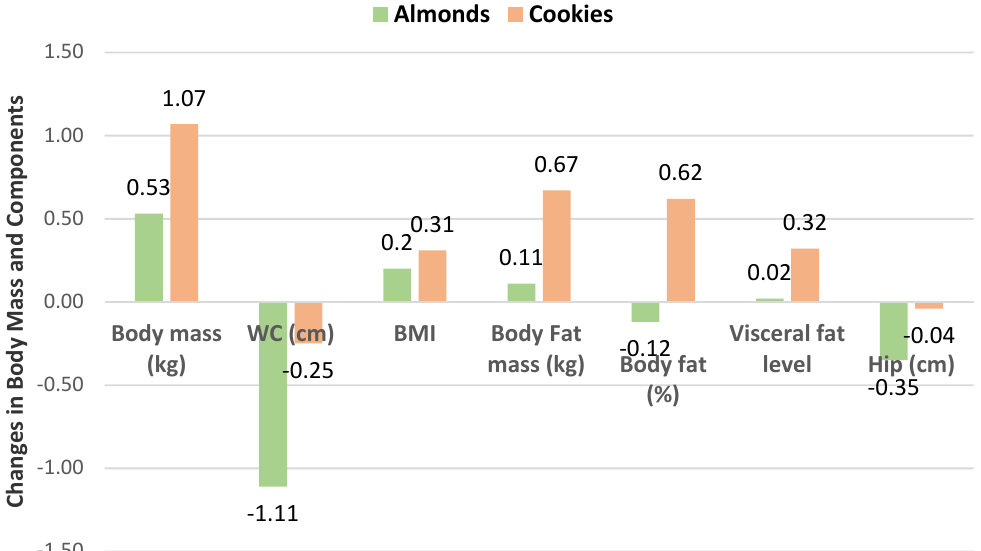
Figure 11. Changes in body mass measures for almonds and control cookie snacking from baseline to 20 weeks [43].